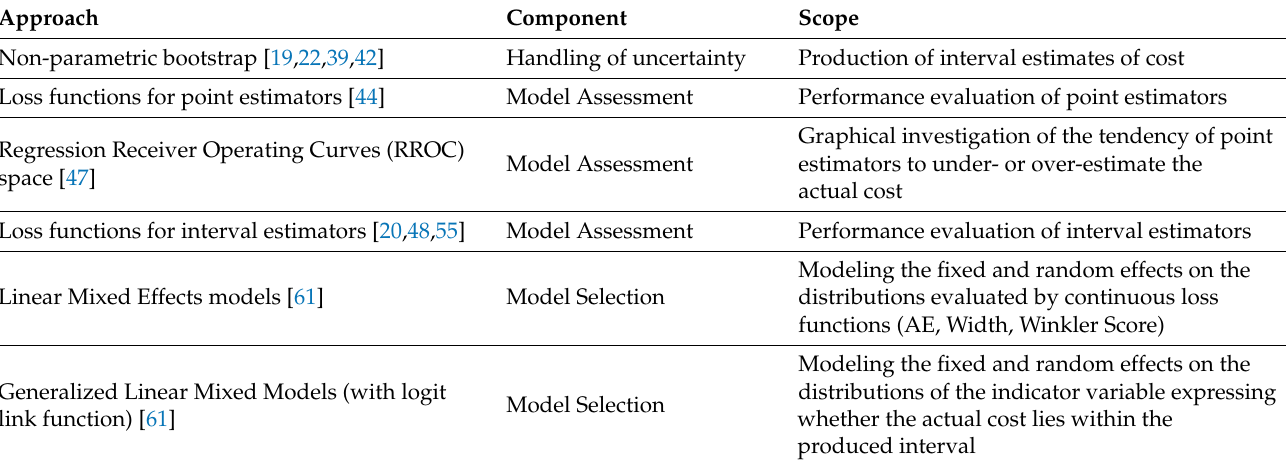
Figure 2. Methodological framework of the study. Table 1. List of adopted approaches and associated components/scopes in the proposed framework.